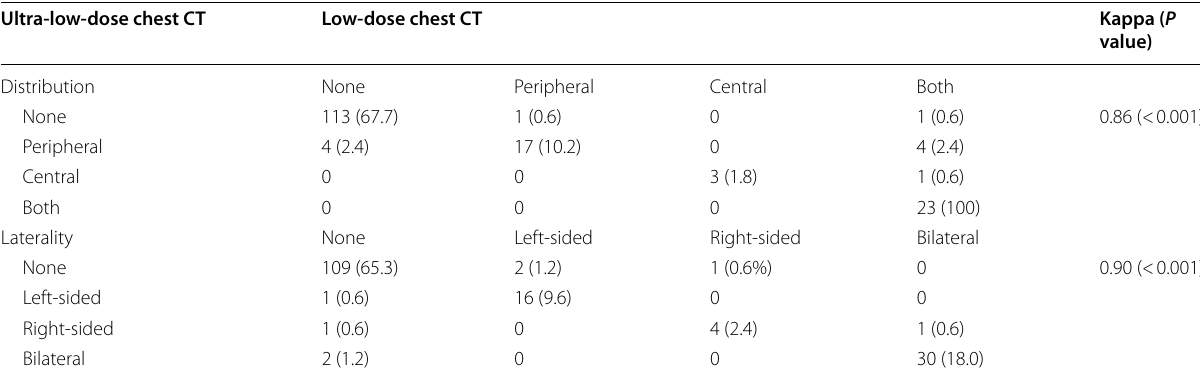
Table 4 Distribution and laterality of the lesions on low‑dose and ultra‑low‑dose chest CT scans among 167 patients Ultra-low-dose chest